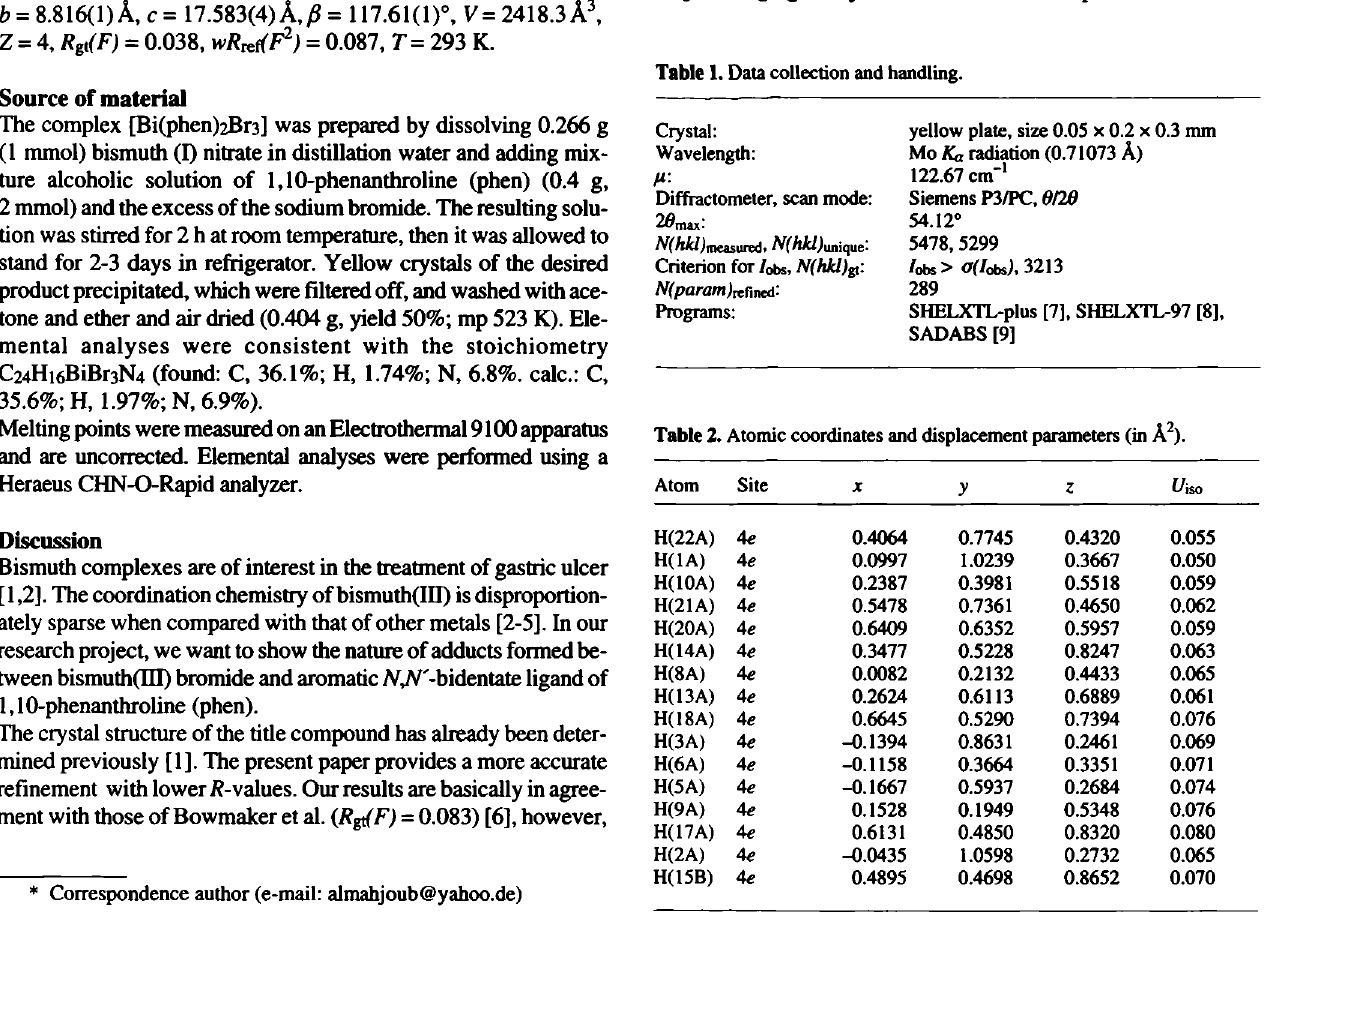
Table 1. Data collection and handling.